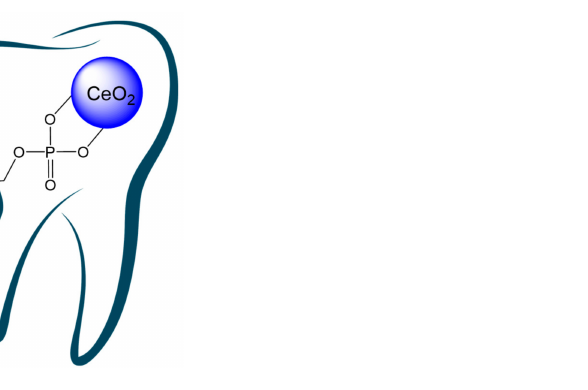
Figure 6. Cerium oxide nanoparticles modified with methacrylate phosphate for possible use as a filler for curing dental polymer